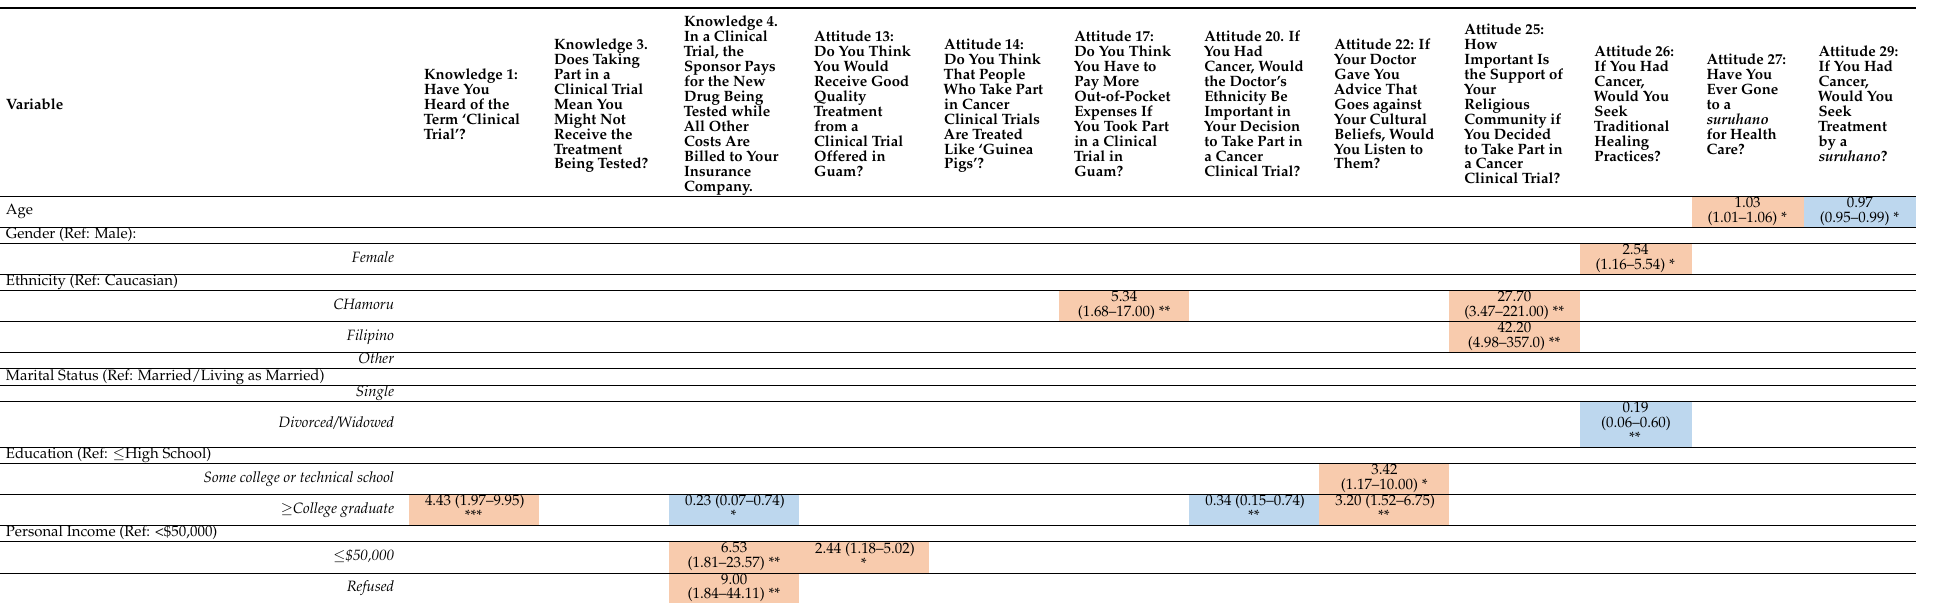
Table 3. Adjusted Odds Ratio and 95% Confidence Interval of Multivariate Logistics